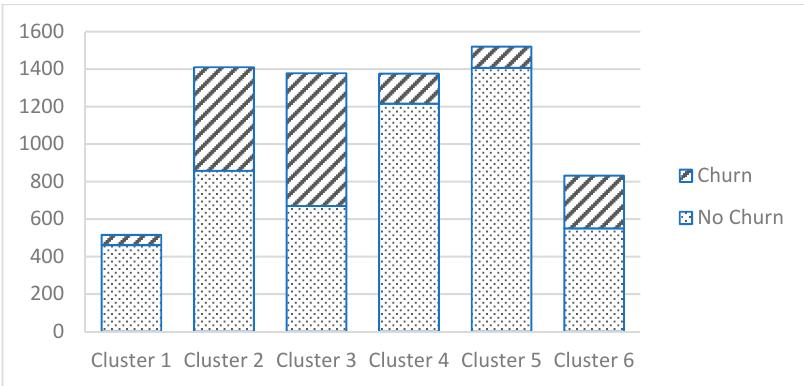
Figure 3. Structures of clusters according to churn. Source: authors’ work.